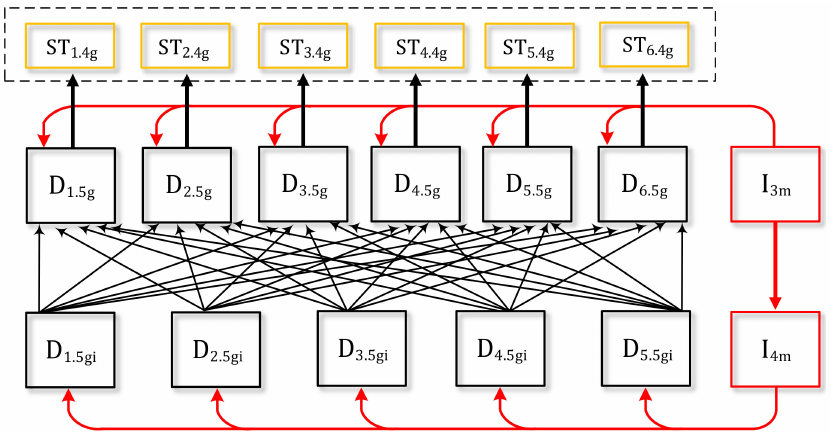
Figure 8. Bipartite subgraph of the choice of means of protection of the TDTN and the requirements for the means of protection of each information